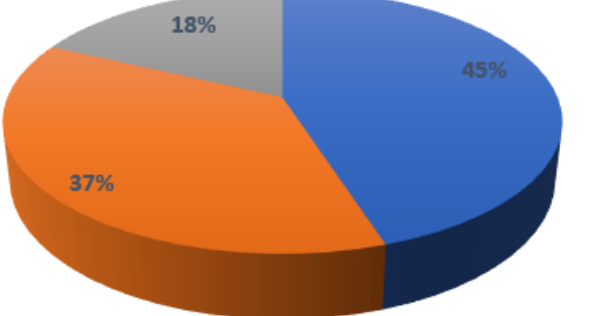
Figure 6. Possibilities for political dialogue. Source: Research data 2019-authors.